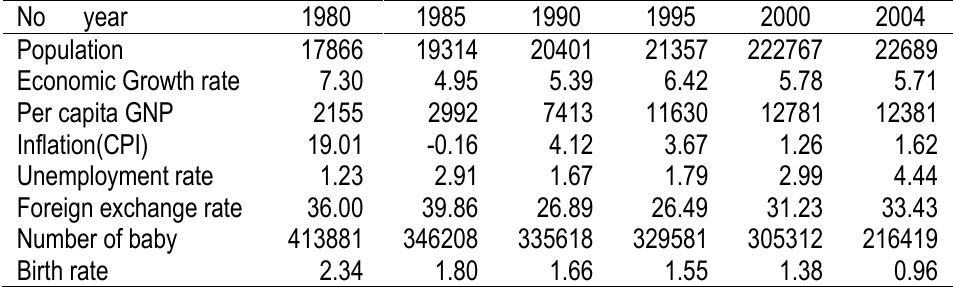
Table 2. The Economic Indicator in Taiwan (Unit: 1000 person, %)